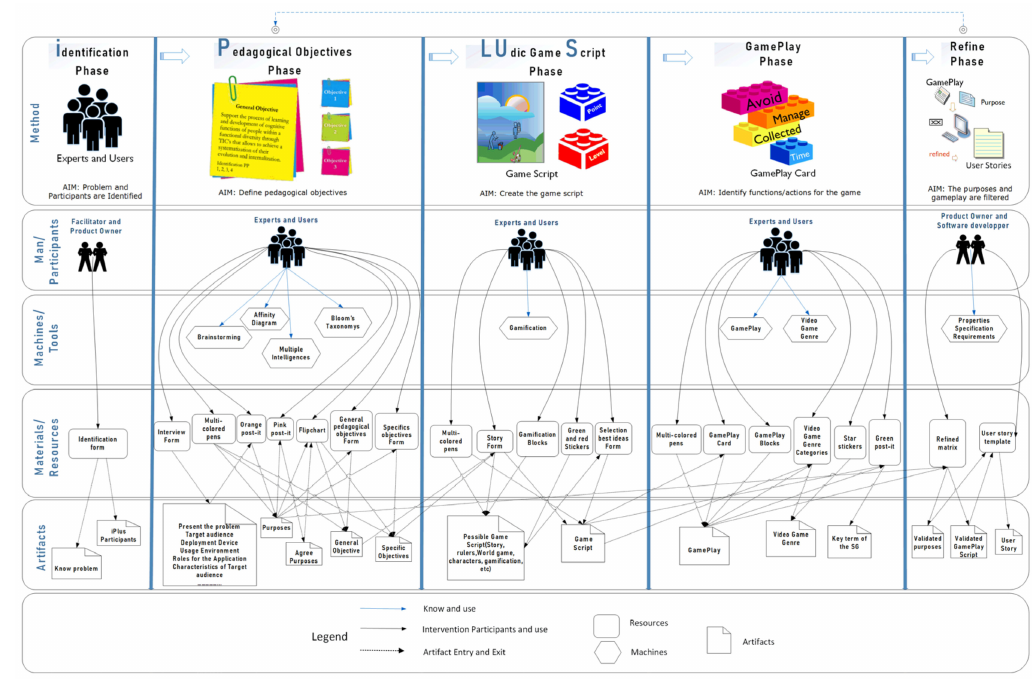
Figure 2. iPlus Methodology